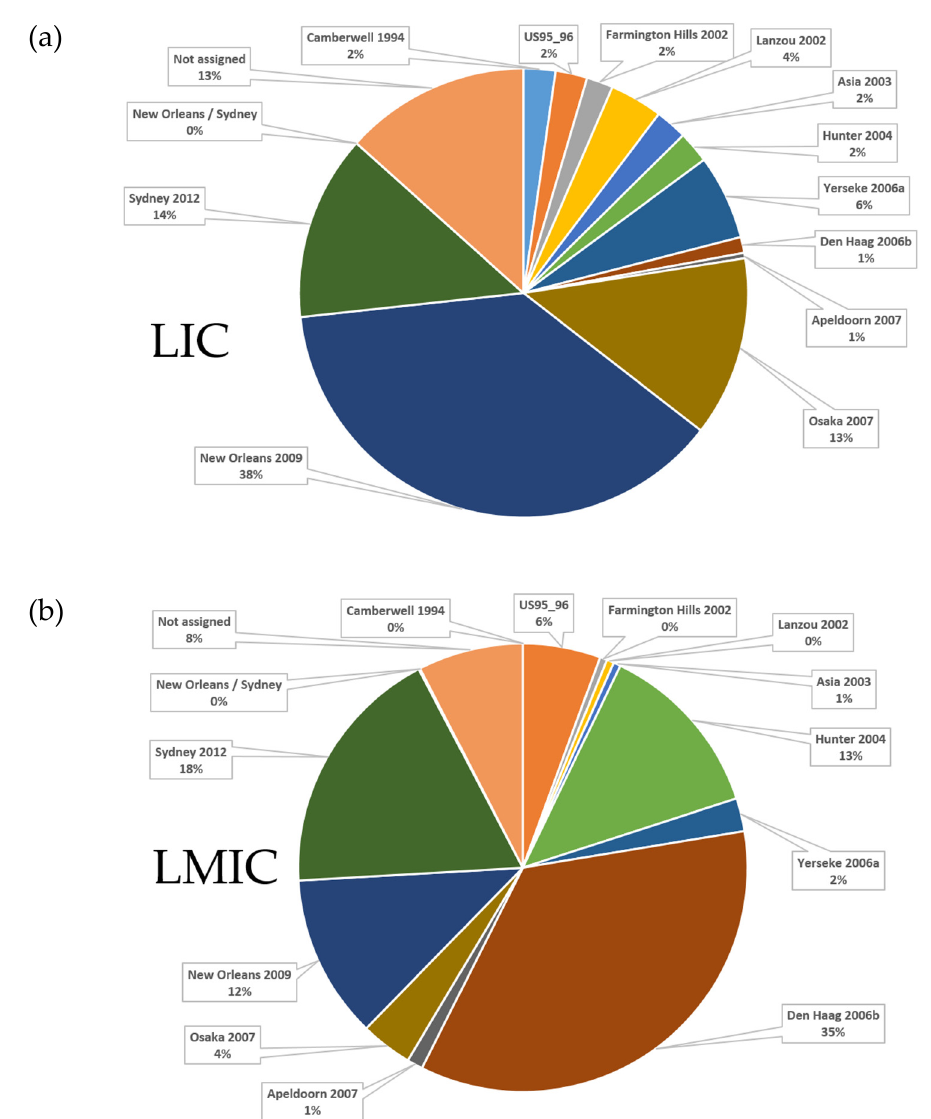
Figure 5. The distribution of norovirus GII.4 variants in ( a ) LIC (5 countries, 9 studies, and 167 typed variants) and ( b ) LMIC (14 countries, 25 studies, and 945 typed variants) between 1997 and 2015. The GII.4 variant was determined based on partial capsid genotyping.